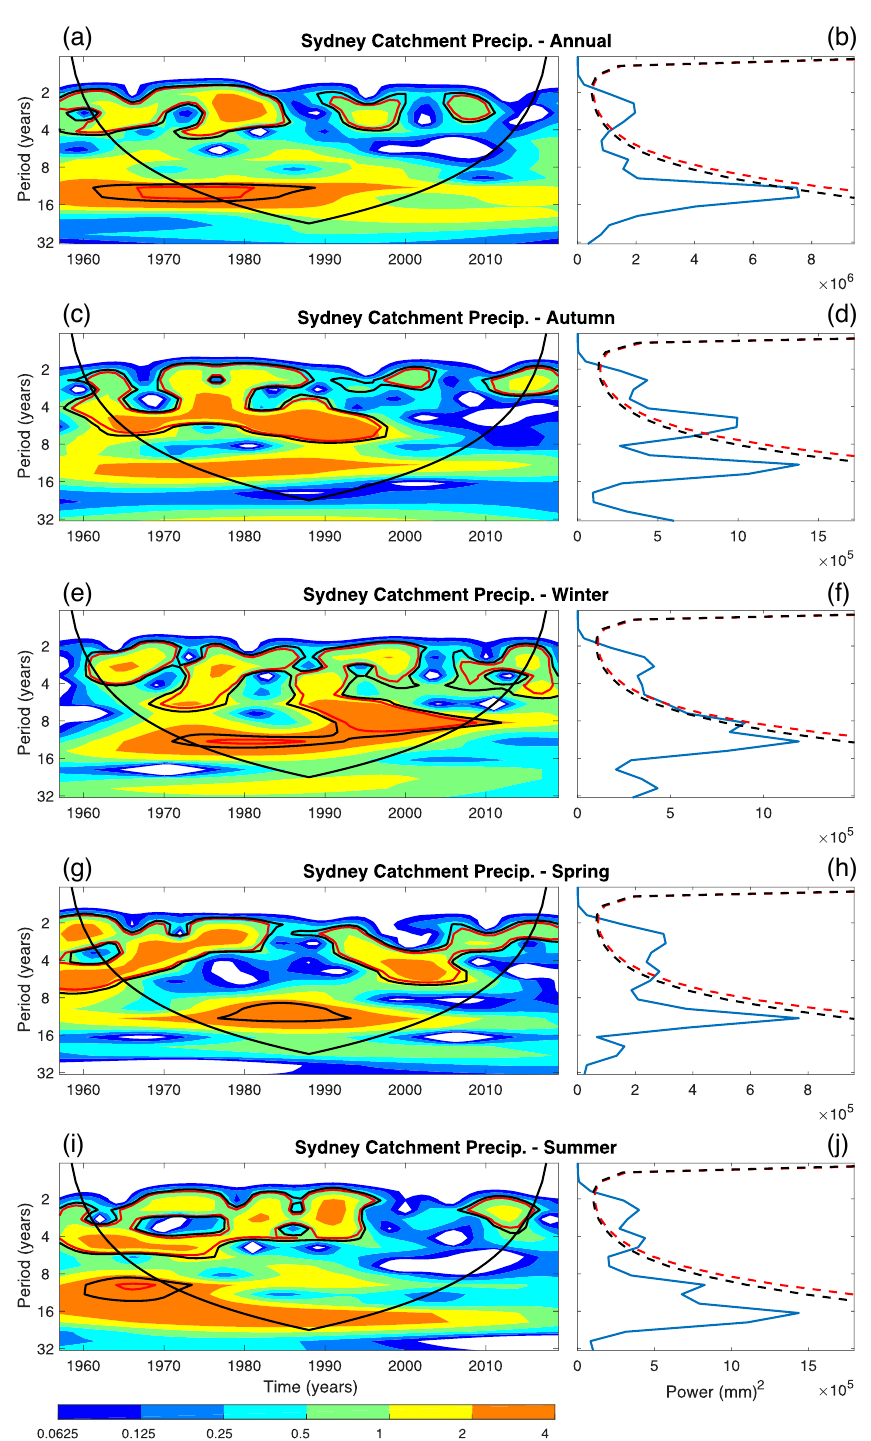
Figure 6. Wavelet analysis for total precipitation across the Sydney catchment area both annually ( a , b ) and over the four seasons ( c – j ). Low values (blue) in the wavelet power spectrum (left panels, ( a , c , e , g , i )) indicate low periodicity, while high values (orange) indicate high periodicity. Horizontal peaks in the global power spectrum (right panel, ( b , d , f , h , j )) indicate high periodicity over the time series. The dashed/solid red (black) line indicates the 95% (90%) confidence level in each plot. The cone of influence is depicted in the wavelet power spectrum by the solid black